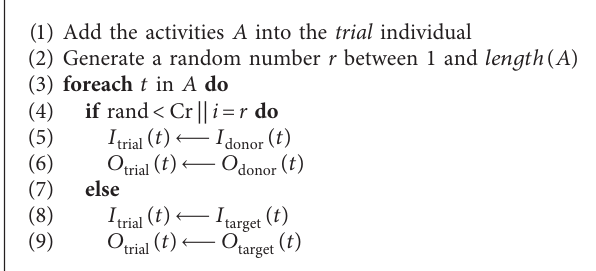
A LGORITHM 2: Pseudocode of the binomial